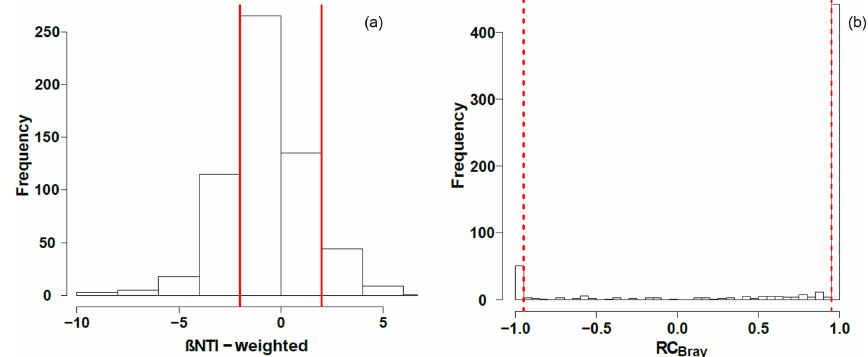
Figure 5. Histograms representing the observed distribution of comparisons based on (a) β -nearest taxon index ( β NTI) and (b) Raup–Crick metric (RC Bray ). Red lines represent the significance thresholds, whereby values outside of their bounds are significantly different from the null